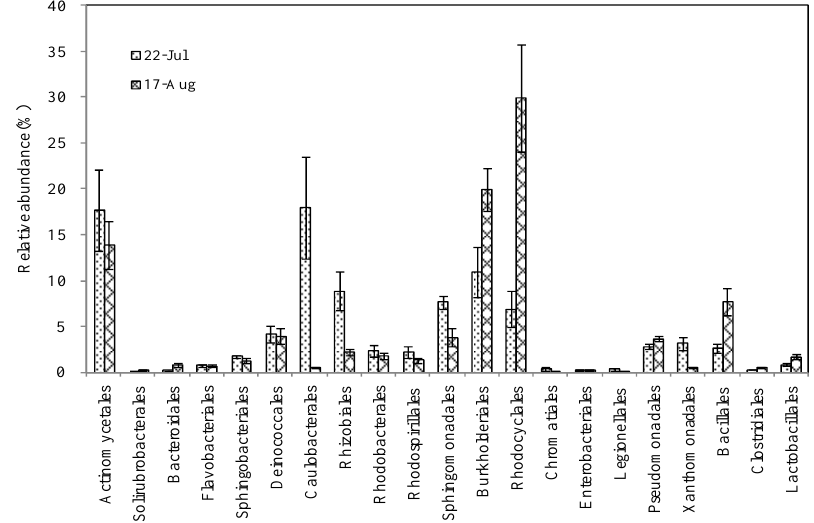
Figure 5. Types and abundance of dominant airborne bacteria at Order taxonomic levels before and after heat events.